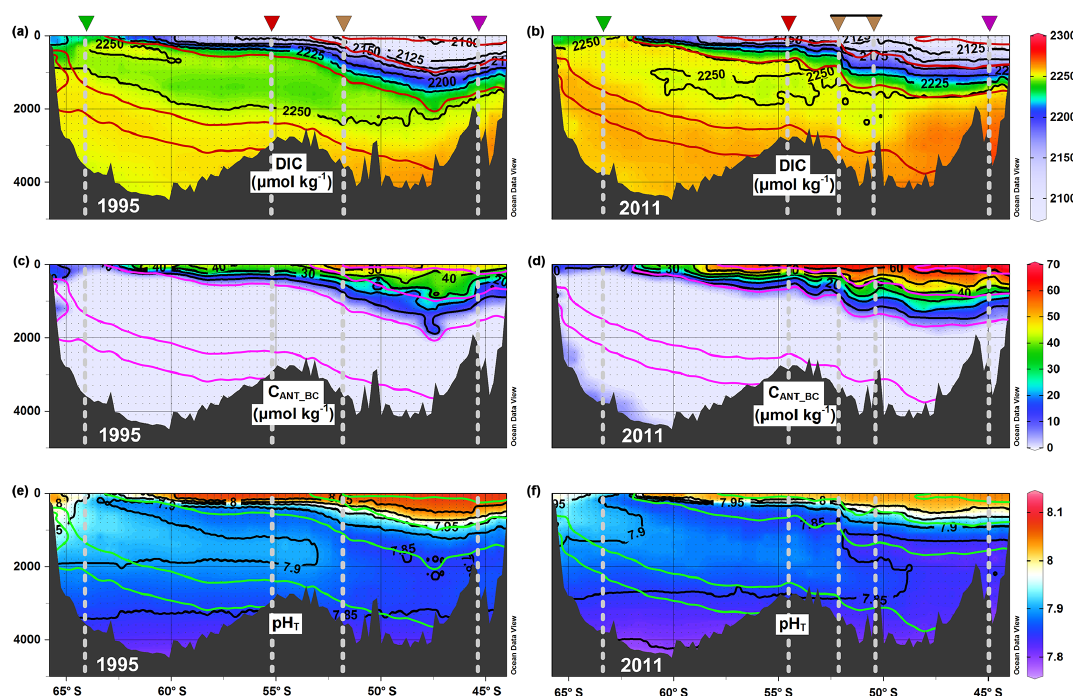
Figure 2. Distribution of DIC (a, b) , C ANT_BC (c, d) and pH T (e, f) in the SR03 section south of Tasmania for the years 1995 (a, c, e) and 2011 (b, d, f) . Red lines in plots (a) and (b) , pink lines in plots (c) and (d) , and green lines in plots (e) and (f) indicate the neutral surfaces that define the different water masses ( γ n ). The position of the fronts (coloured triangles and grey dotted lines) in each of the cruises is also